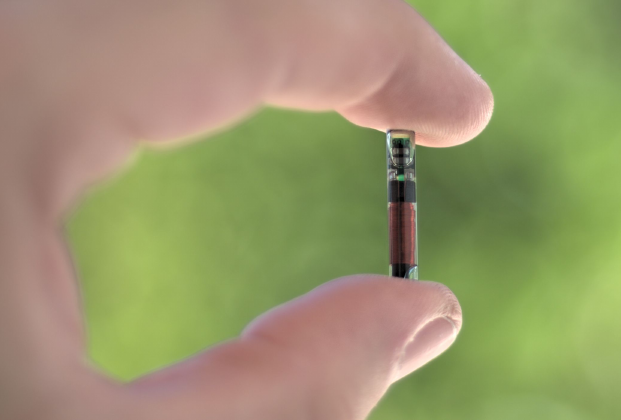
Figure 21. One of the animal identification tags